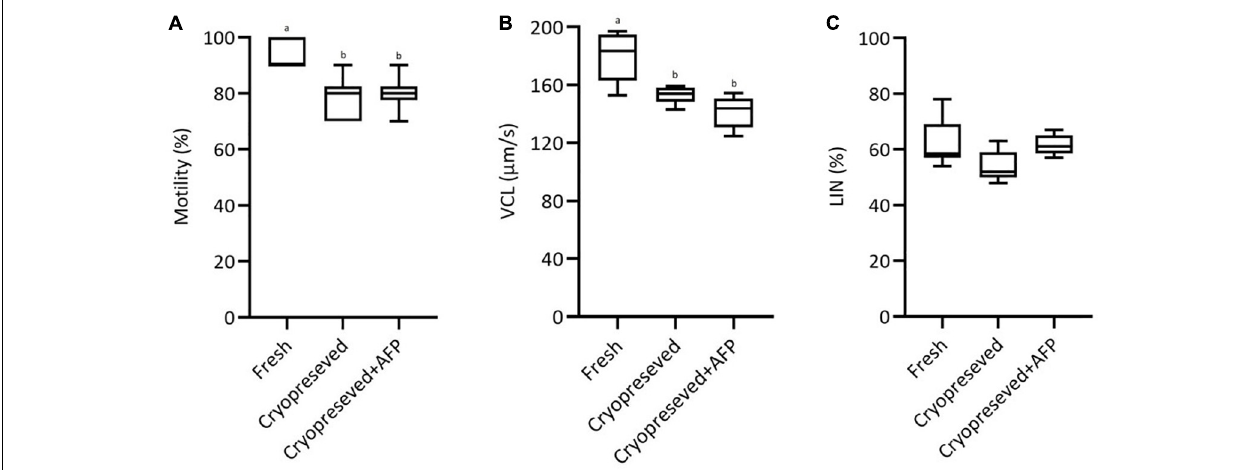
FIGURE 1 | Effect of cryopreservation on motility parameters at 15 s post-activation in fresh, cryopreserved, and cryopreserved spermatozoa with supplementation of 10 µ g/mL AFPI (cryopreserved + AFP) in sterlet: (A) motility; (B) curvilinear velocity (VCL); (C) linearity (LIN). Values with different lower-case letters are significantly different [ p < 0.05, one-way analysis of variance (ANOVA) followed by Tukey’s honest significant difference test].